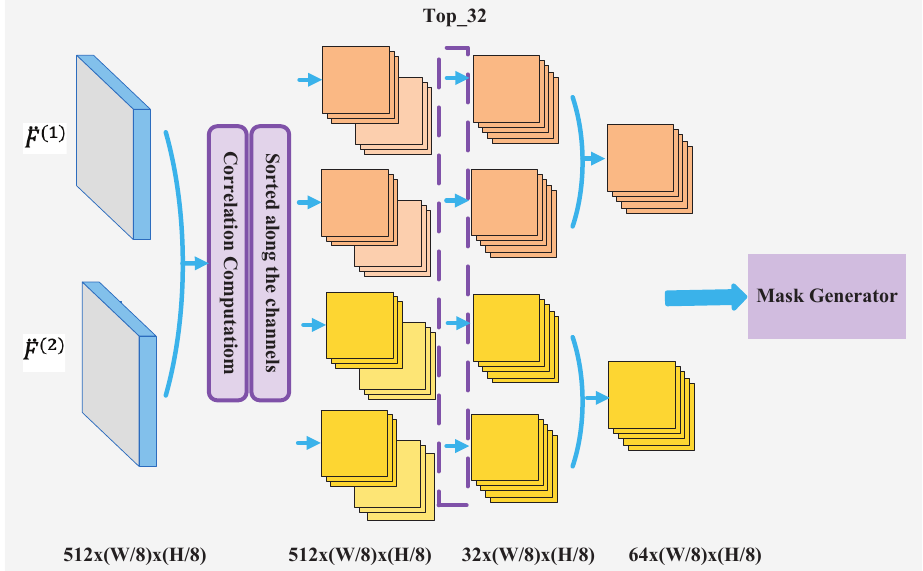
Figure 3. Truncation operations of Scale-Adaptive Correlation Computation module. ¨ F ( 1 ) , ¨ F ( 2 ) are generated from SE blocks. “Top_32 ” means that we sort each correlation map along the H /8 × W /8 channels to select Top_32 values.